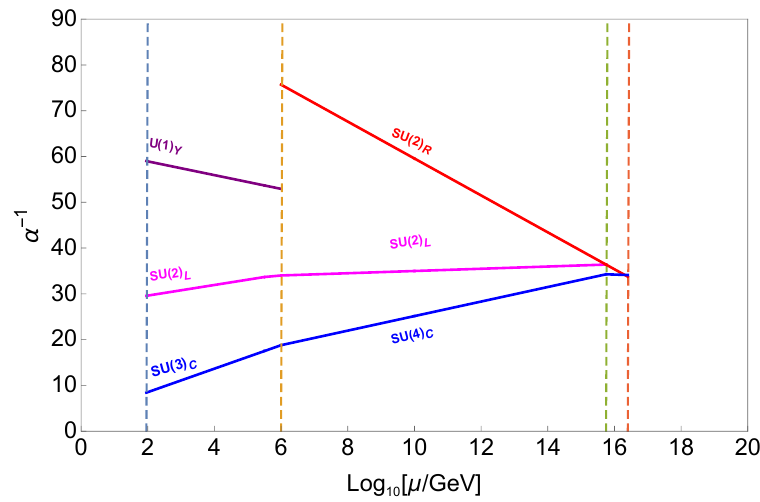
Figure 1 . Gauge coupling uni(cid:12)cation for a PeV scale left-right symmetric framework explaining IceCube data via decaying dark matter. The gauge couplings unify at M U = 10 16 : 85 GeV whereas other intermediate mass scales are M D 10 15 : 6 GeV (D-parity breaking scale), M R (cid:25) ( W R mass at the Pati-Salam symmetry breaking